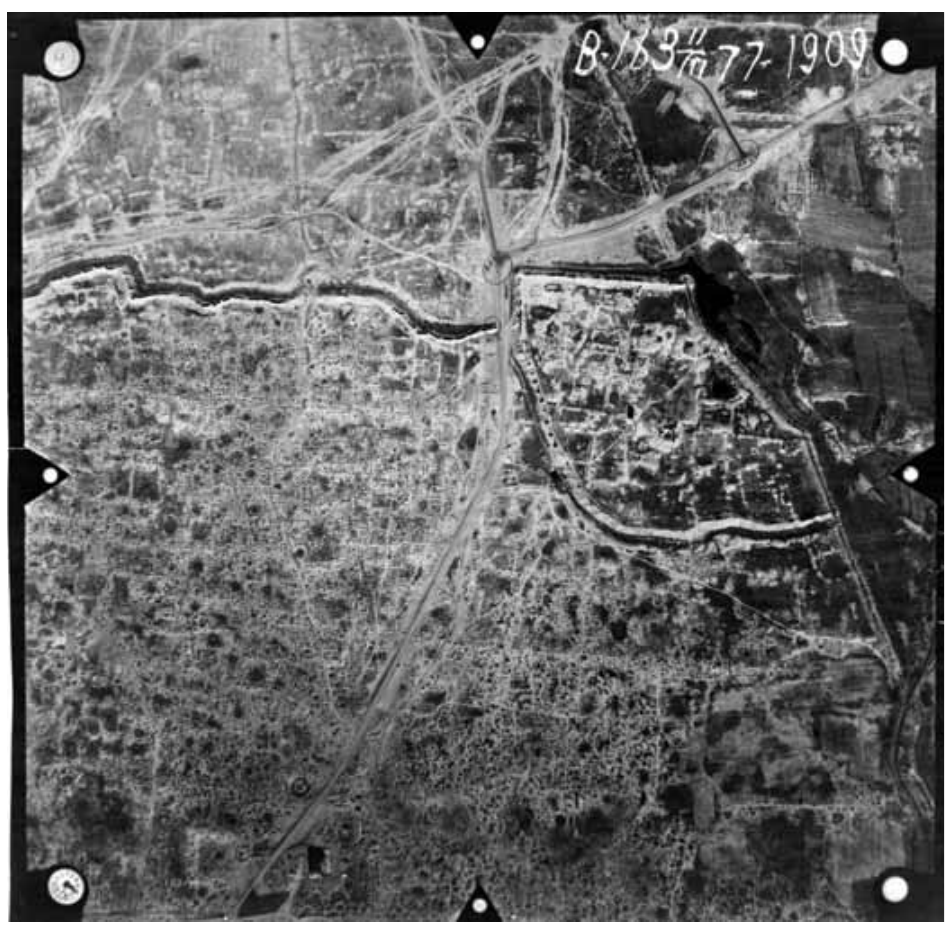
Fig. 3: Soviet (1970s) vertical air photograph covering the north central part of Sultan Kala, with the citadel (Shahriyar Ark) visible upper right and the Madj ā n Canal winding its way northward